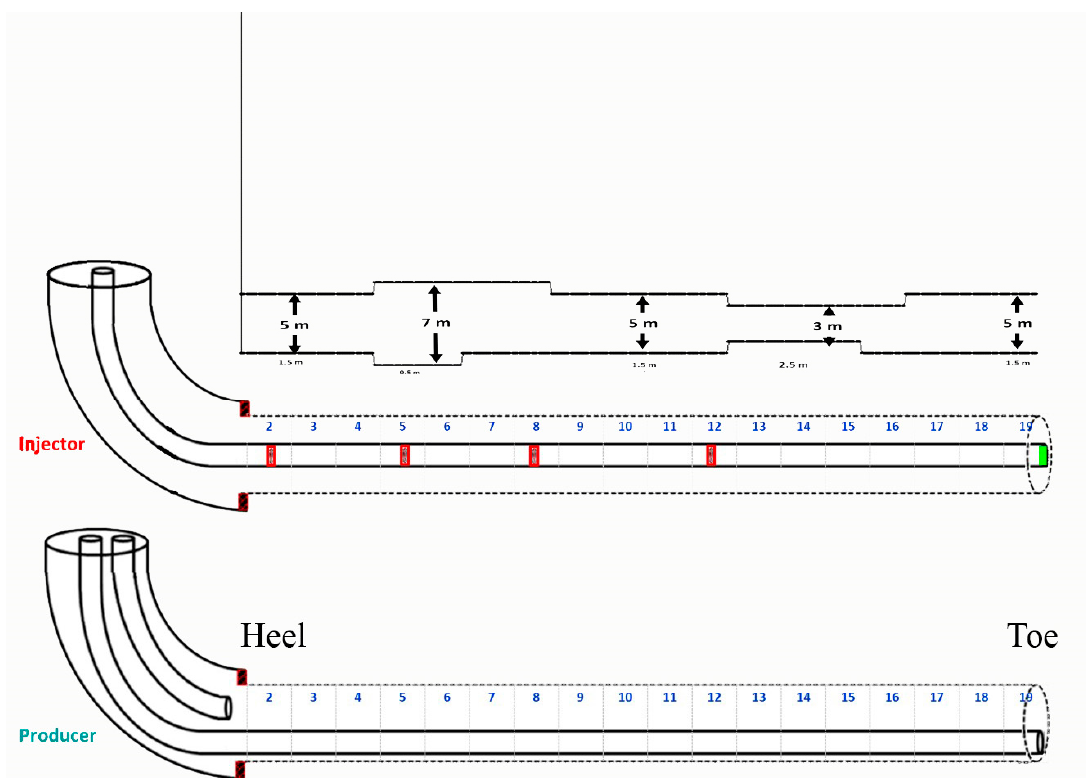
Figure 3. Well completion scheme for tubing-deployed OCDs.